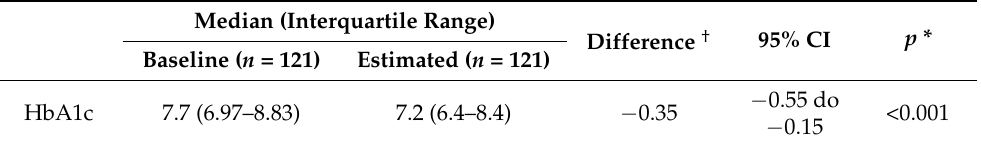
Table 5. Difference between baseline and estimated HbA1c.